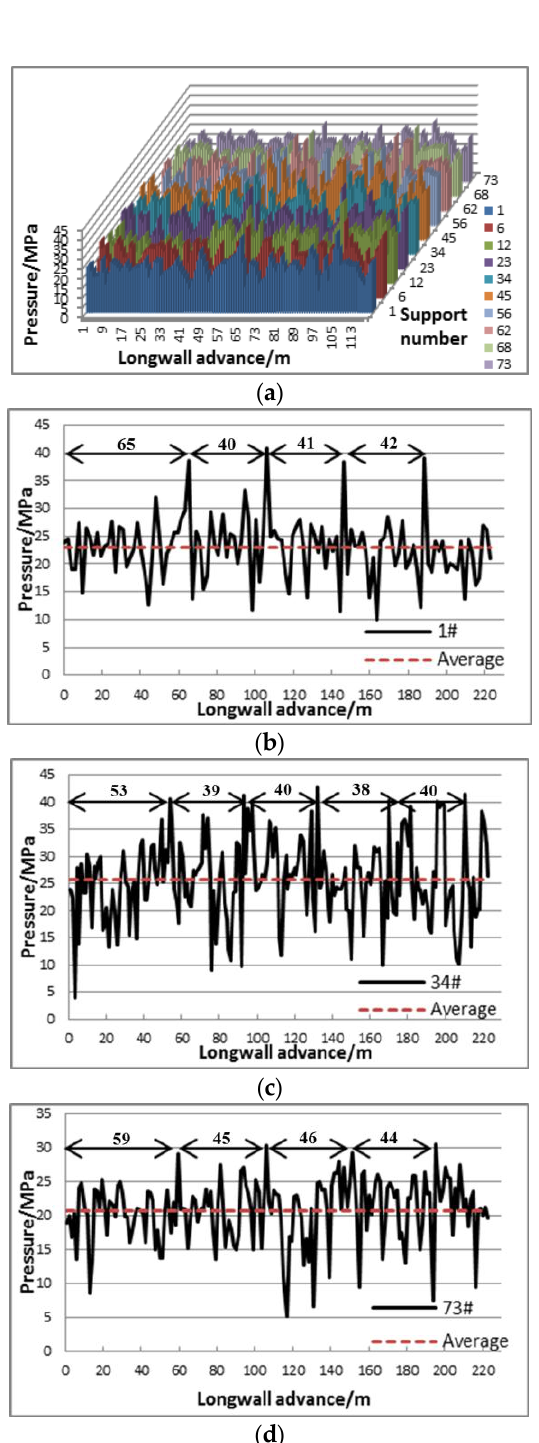
Figure 11. Monitoring results of hydraulic supports at typical positions: ( a ) Overall pressure monitoring of supports; ( b ) #1 support (far from the roof cutting side); ( c ) #34 support (in the middle of the longwall working face); ( d ) #73 support (near the roof cutting side).